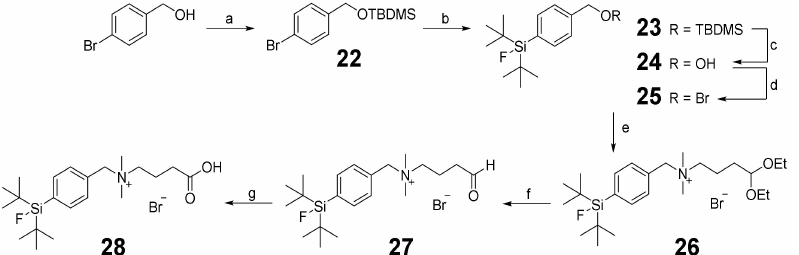
Scheme 3. Schematic depiction of the synthesis of SiFA lin acid 28 . Conditions: ( a ) TBDMS-Cl, imidazole, DMF, 98% yield; ( b ) SiF 2 ( t Bu) 2 , t BuLi, Et 2 O, 92% yield; ( c ) HCl, MeOH, 99% yield;